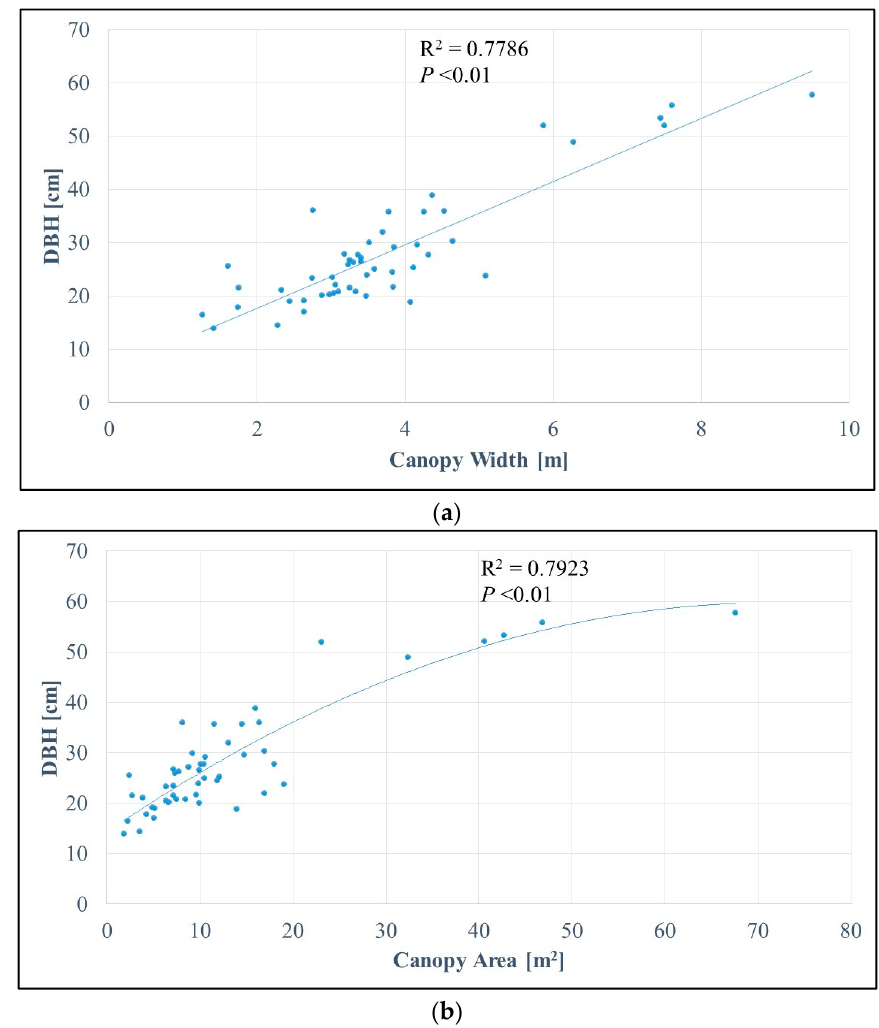
Figure 5. Analysis of the relationships between observed Diameter at Breast Height (DBH) and ( a ) canopy width (m) and ( b ) canopy area (m 2 ). The former shows a linear relationship of R 2 = 0.7786, and the latter shows a second-order polynomial regression line as the reference (R 2 = 0.7923). Pearson’s correlation analysis indicates the probability value ( p -value) of less than 0.01.